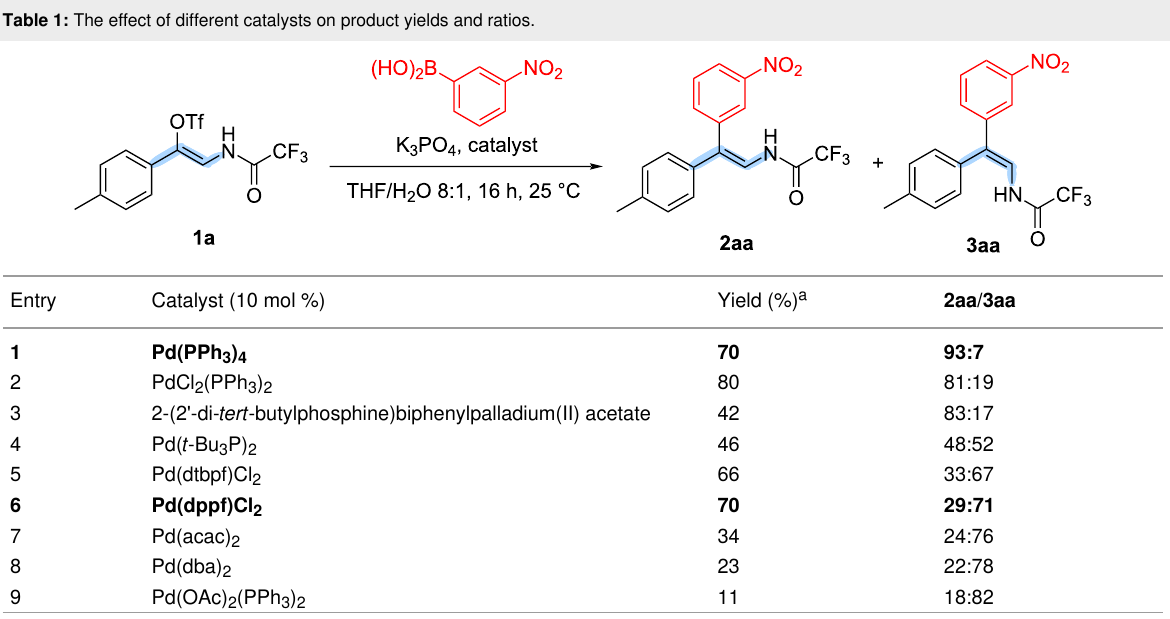
Table 1: The effect of different catalysts on product yields and